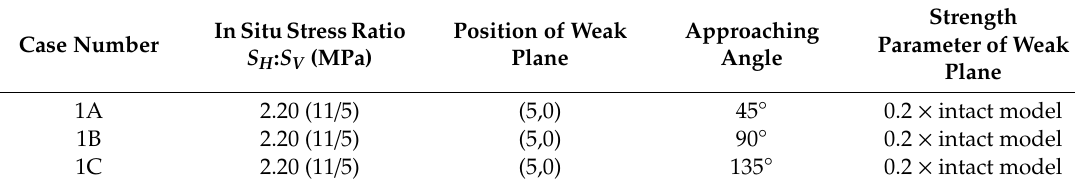
Table 4. Experimental scheme for the study of interactions between hydraulic fractures (HFs) and weak planes (WPs) under di ff erent fluid